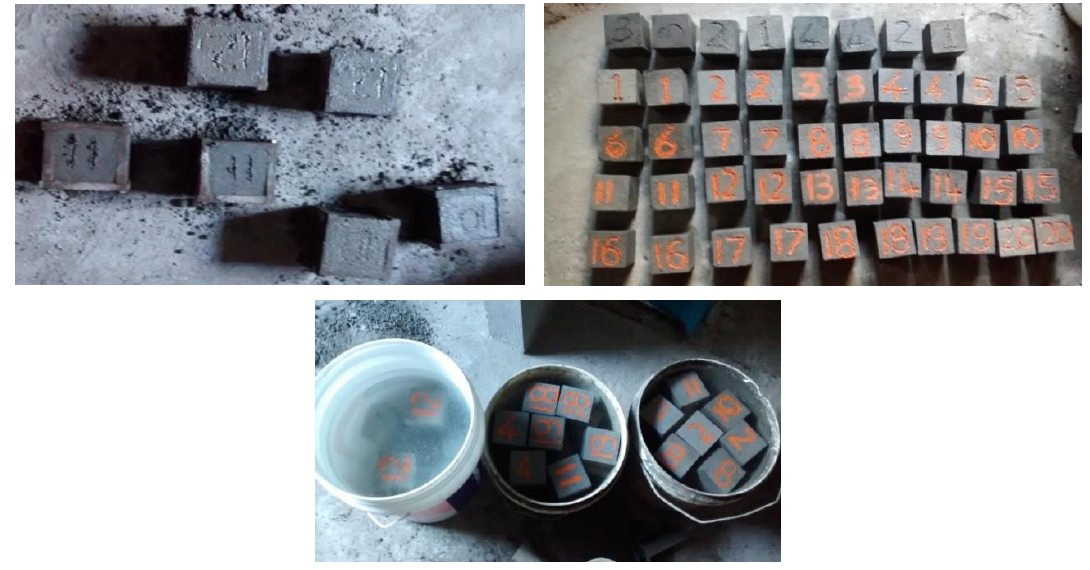
Figure 8. Casting and curing of specimens.